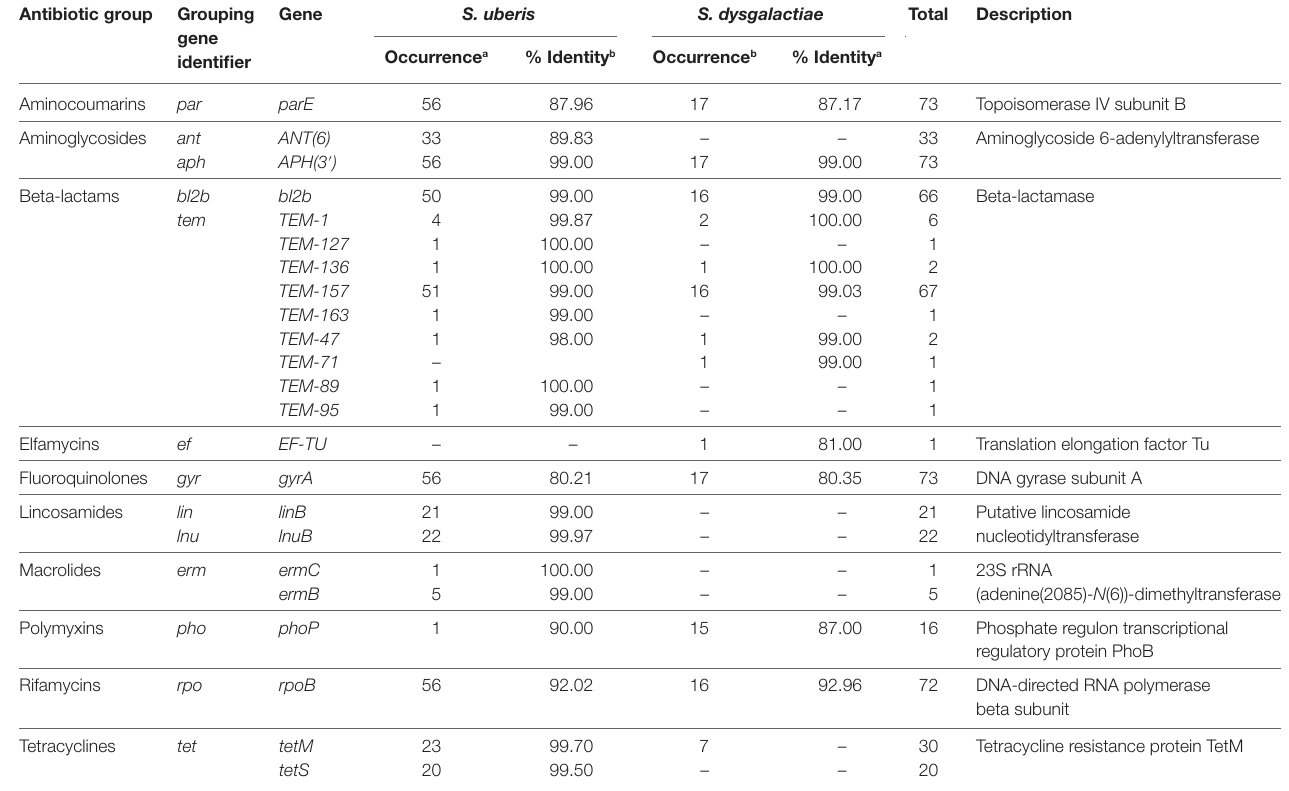
TaBle 2 | Occurrence of antimicrobial resistance (aMr) genes and mean identity values identified in the genomes of 56 isolates of Streptococcus uberis and 17 isolates of Streptococcus dysgalactiae recovered from dairy cows on 18 herds in the Maritime Provinces of canada, 2007 and 2008. antibiotic group grouping